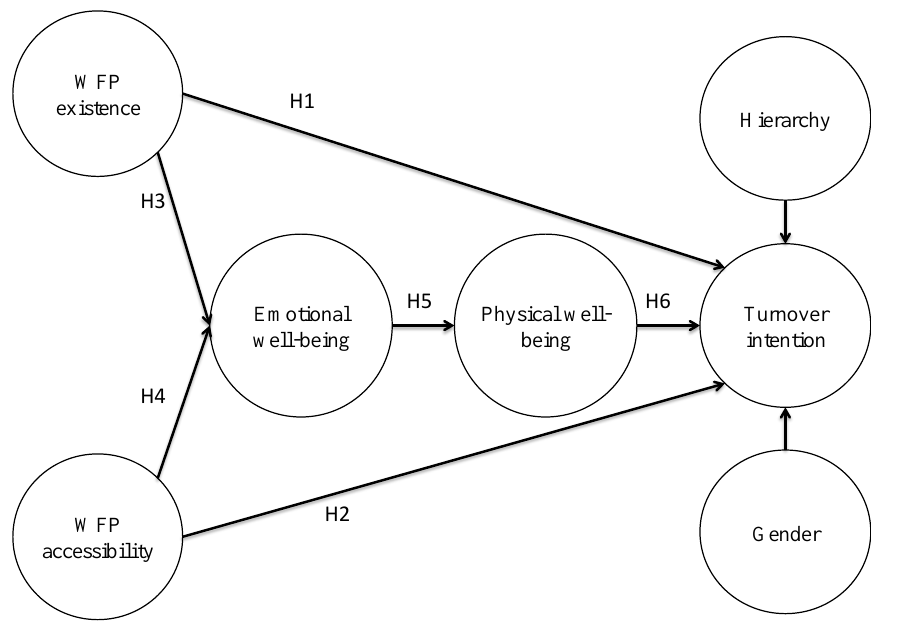
Figure 1. Theoretical model and hypotheses.